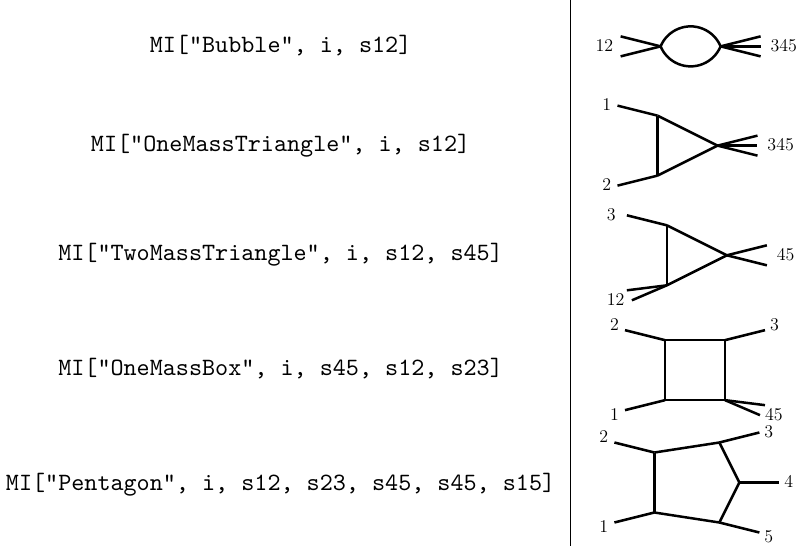
Table 8. Permutation representatives for one-loop master integral topologies. For one-loop master integrals we use the basis of [69], which includes only a certain subset of IBP relations (those that are independent of D ). The basis thus includes integrals that would be reducible if one were to use the full set of IBP relations, such as all "OneMassTriangle" masters. The advantage of using this basis is that the coefficients in (3.3) are D -independent.